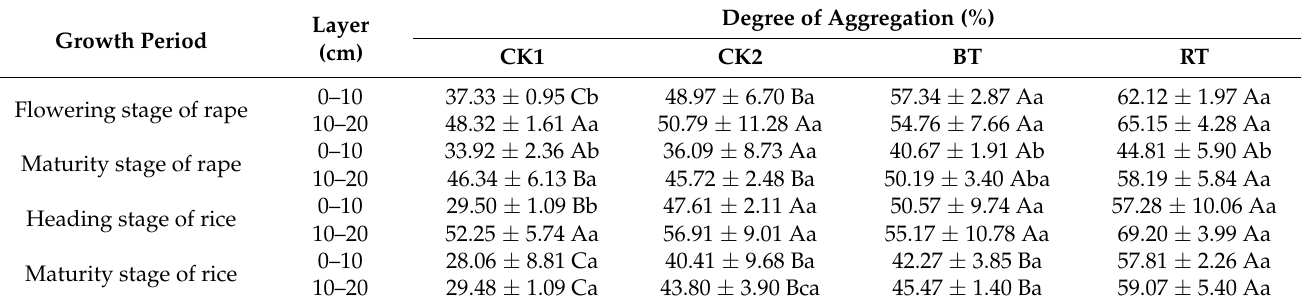
Table 2. Soil particle aggregation of rape and rice under different tillage